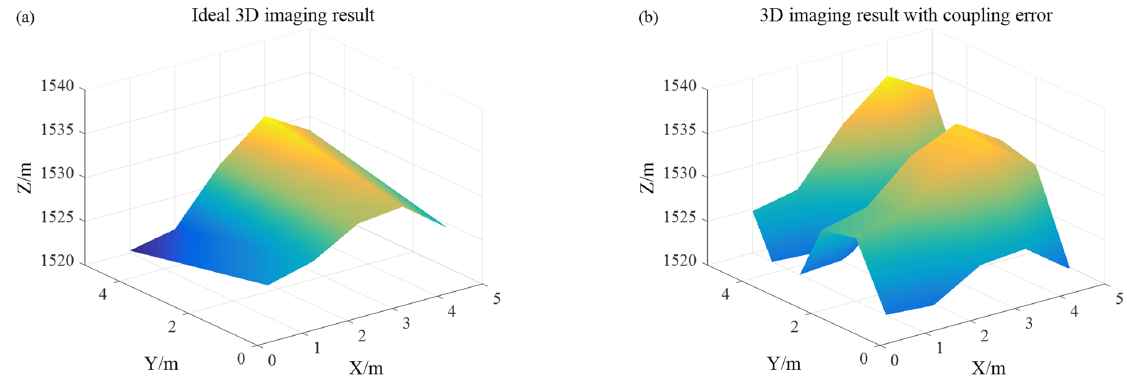
Remote Sens. 2021 , 13 , x FOR PEER REVIEW